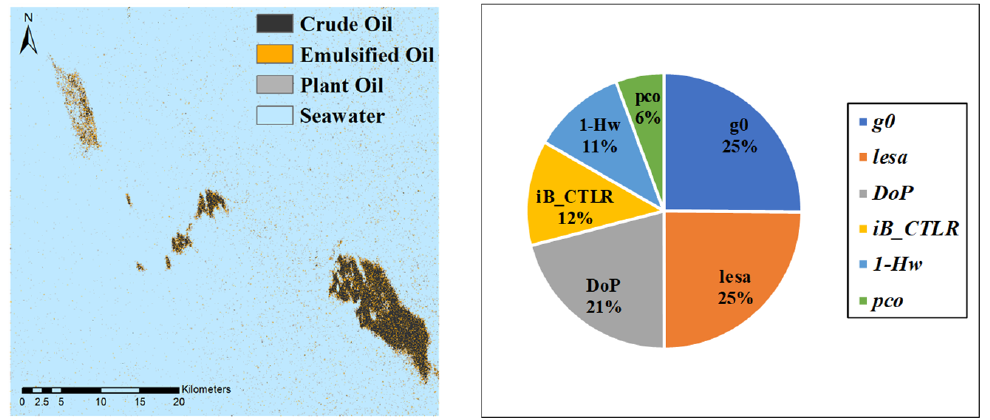
Figure 16. Random forest classification result graph and variable importance ranking for Case 3.